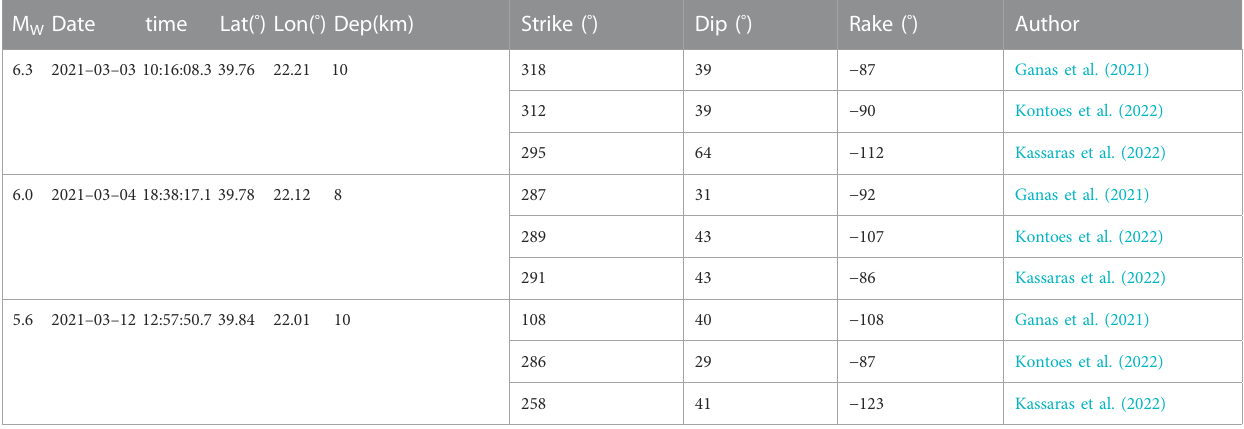
TABLE 1 Focal mechanisms of the three mainshocks of the Thessaly seismic sequence computed by Ganas et al. (2021), Kontoes et al. (2022) and Kassaras et al.